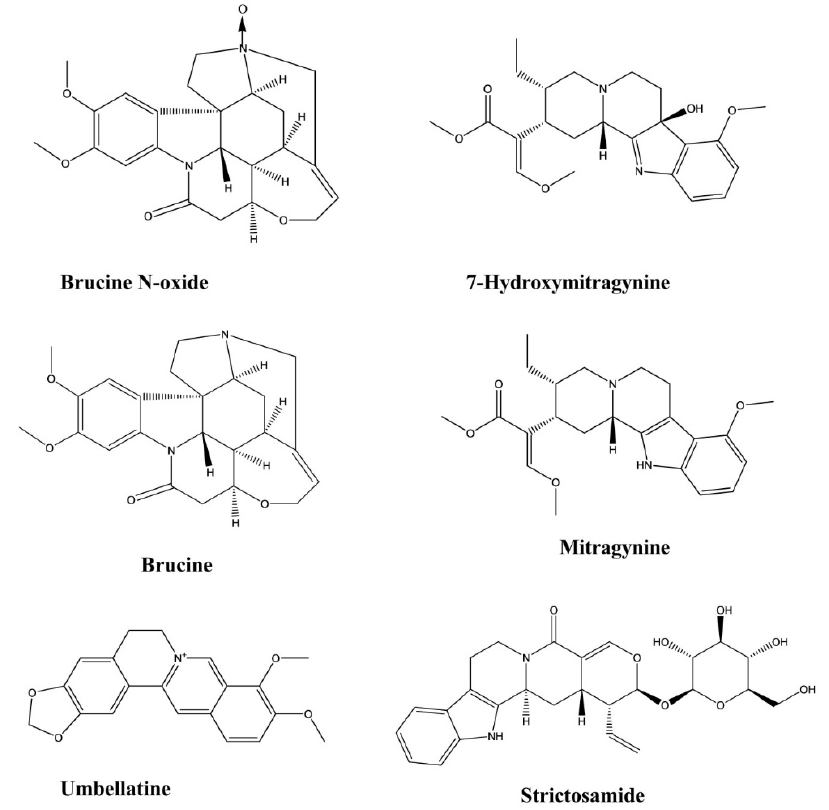
Figure 7. Analgesic activity of indole